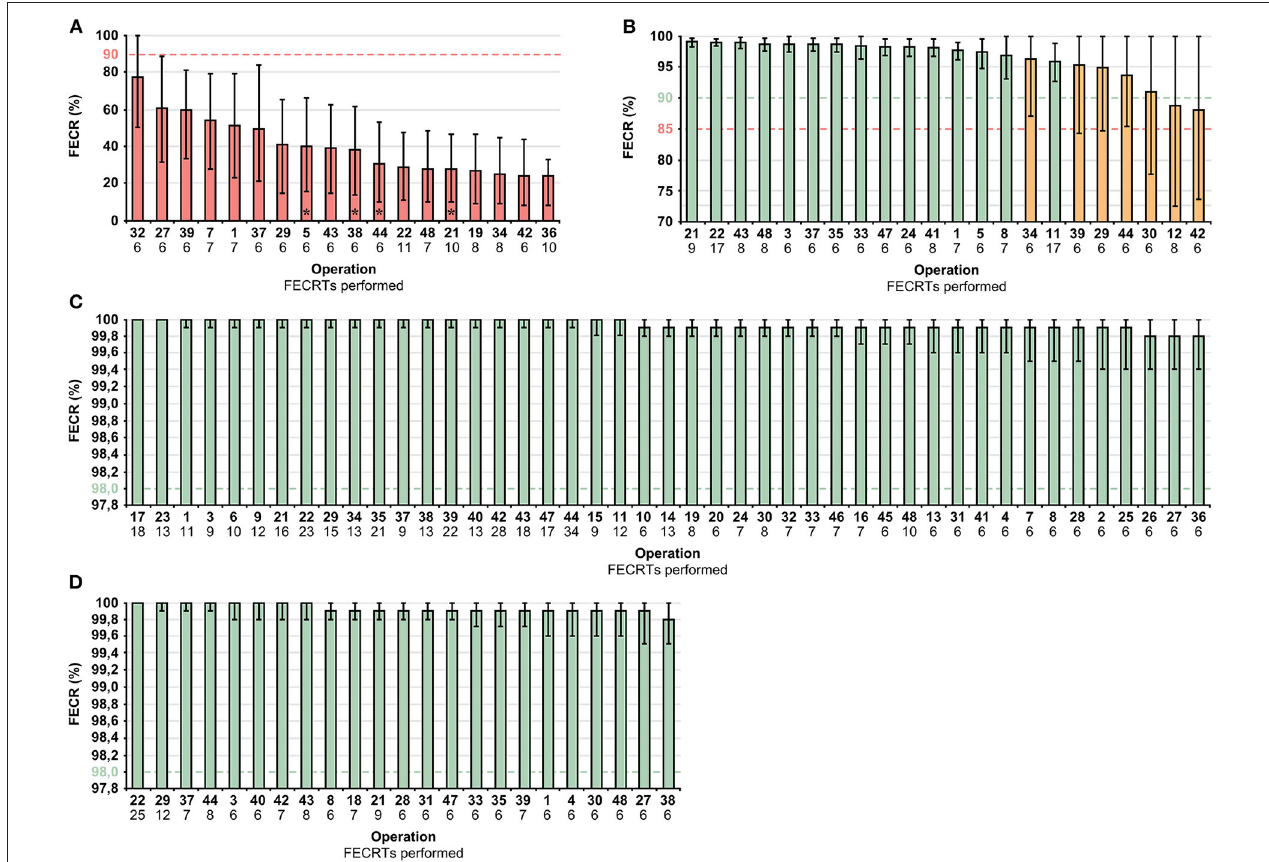
FIGURE 3 | Estimated efficacies of FBZ (A) , PYR (B) , IVM (C) and MOX (D) (normal, green; suspected, orange; reduced, red) based on FECR% and 95% LLCI at the operation level. The dashed lines represent the criteria for estimating FECR% efficacy for each anthelmintic, error bars 95% CI (credible interval), *sub-zero efficacy at operation level (mean FECRT < 0%). FBZ, fenbendazole; FECR%, mean fecal egg count reduction; IVM, ivermectin; MOX, moxidectin; PYR, pyrantel embonate; 95% LLCI, lower limit of 95% credible